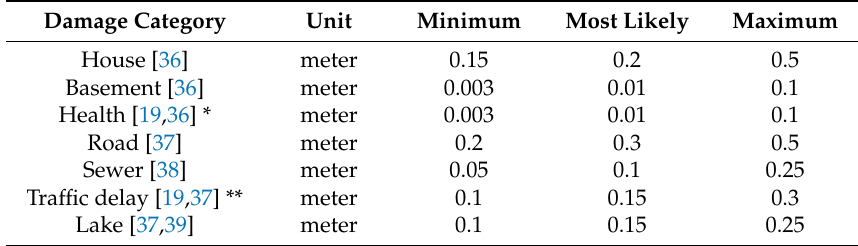
Table 2. Uncertainty ranges for stage-damage relationships for each item that can be damaged.